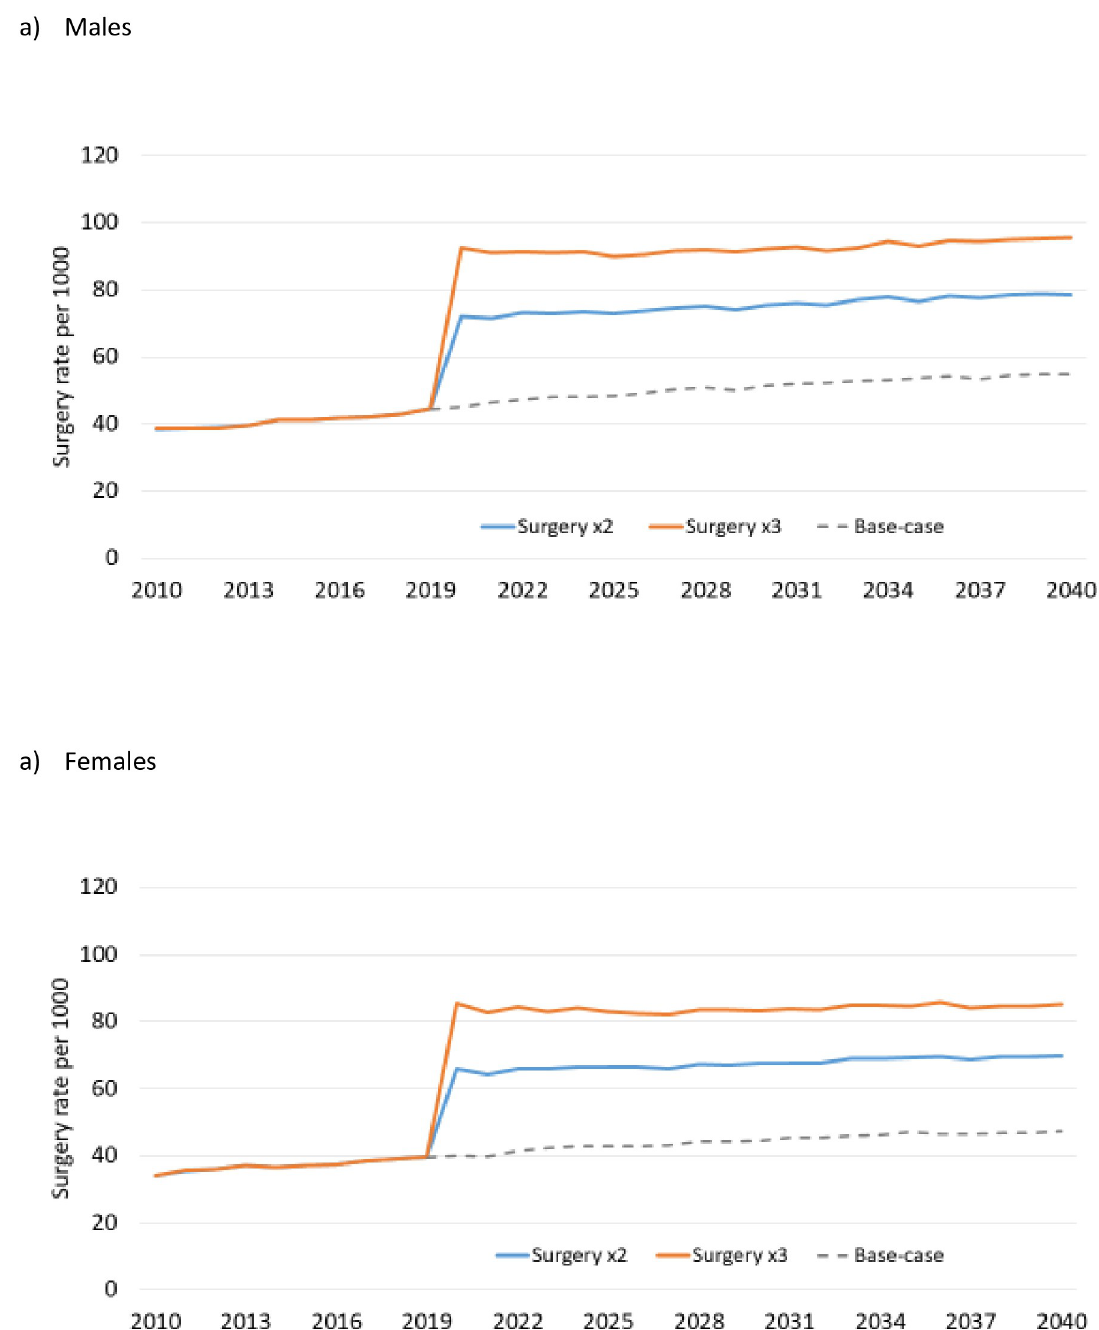
Fig 2. Joint replacement rates before and after Surgery x2 and Surgery x3 interventions in people with osteoarthritis. All interventions are described in Table 1.